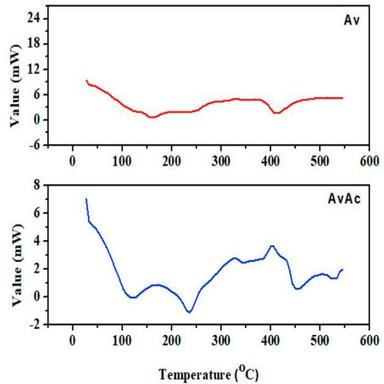
DSC thermogram of Av and AvAc powder.